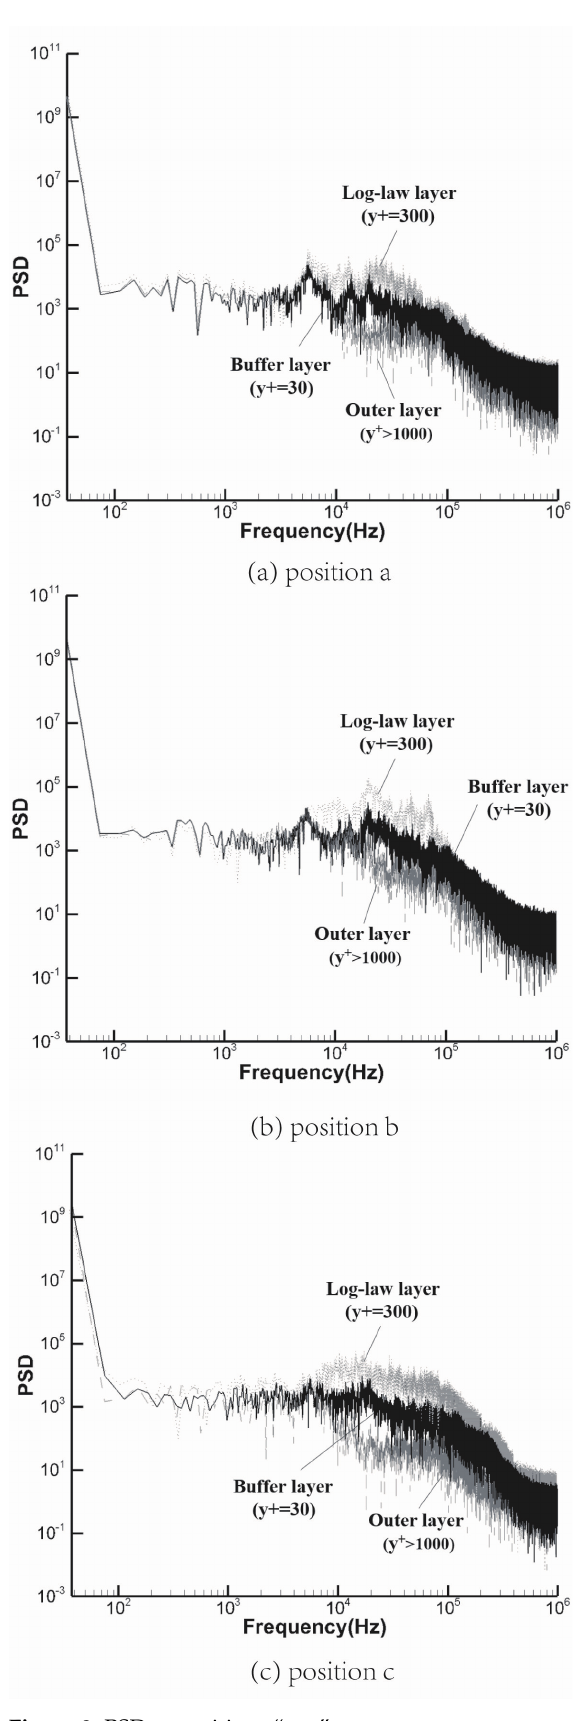
Figure 8. PSD at positions